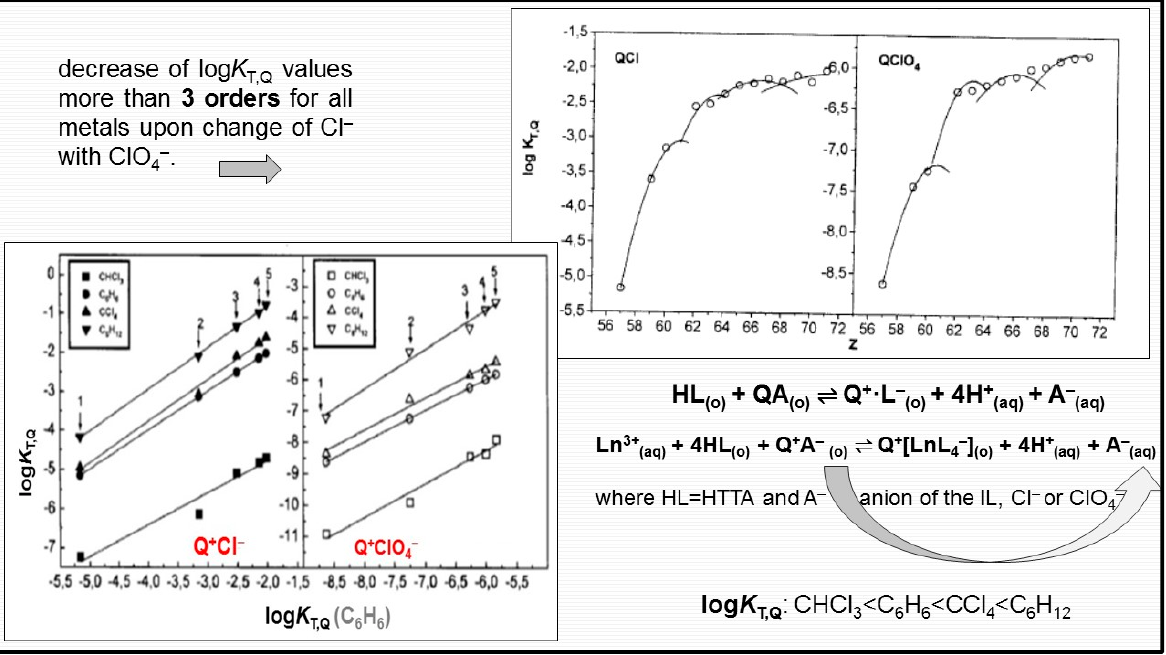
Figure 10. Variation of log K T,Q with atomic number (Z) for lanthanoid extraction with HTTA − QCl(QClO 4 ) mixtures in C 6 H 6 . Comparison of log K T,Q for CHCl 3 , C 6 H 6 , CCl 4 , and C 6 H 12 with log K T,Q for C 6 H 6 (1 − La, 2 − Nd, 3 − Eu, 4 − Ho and 5 − Lu). Adapted from Ref. [46] and Ref. [137]